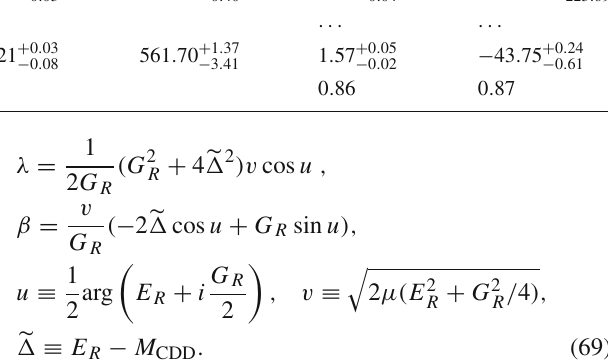
Table 3 Parameters characterizing the S -wave interaction t ( E ) for cases 1–3.II of the combined fits in Sect. 6. The ellipses indicate that it is not appropriate to give the corresponding magnitude in such case. The elementariness Z is calculated from the knowledge of the bound-state mass and the Weinberg’s compositeness relations of Eq. (84) either in terms of a ( Z a ) or r ( Z r ). The error is not given when its estimation is smaller than the precision